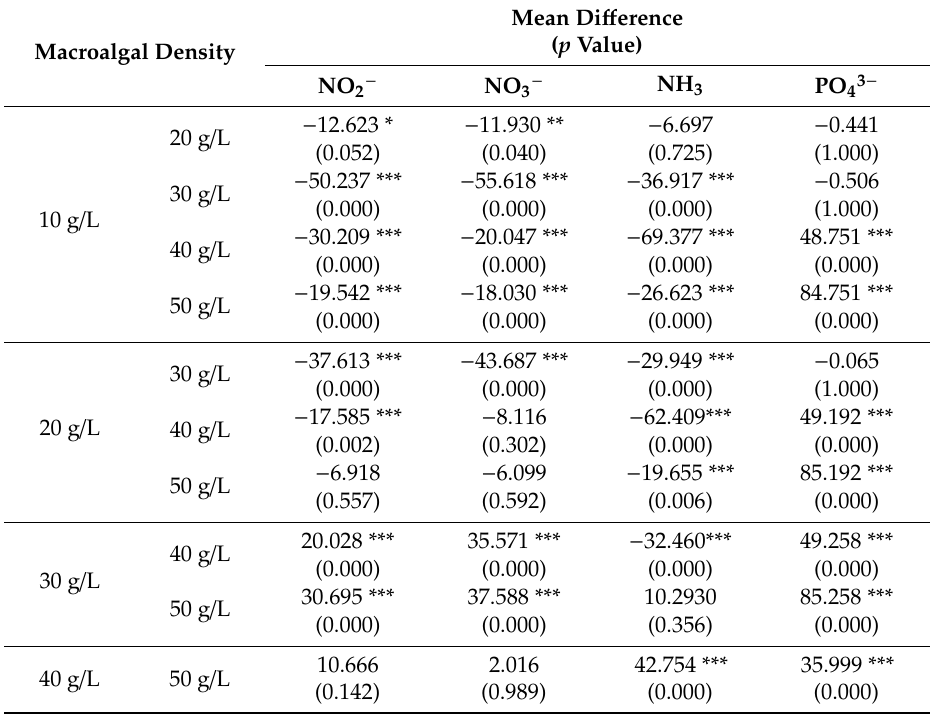
Table 2. Tukey’s HSD (honesty significant di ff erence) test results for five di ff erent macroalgal density